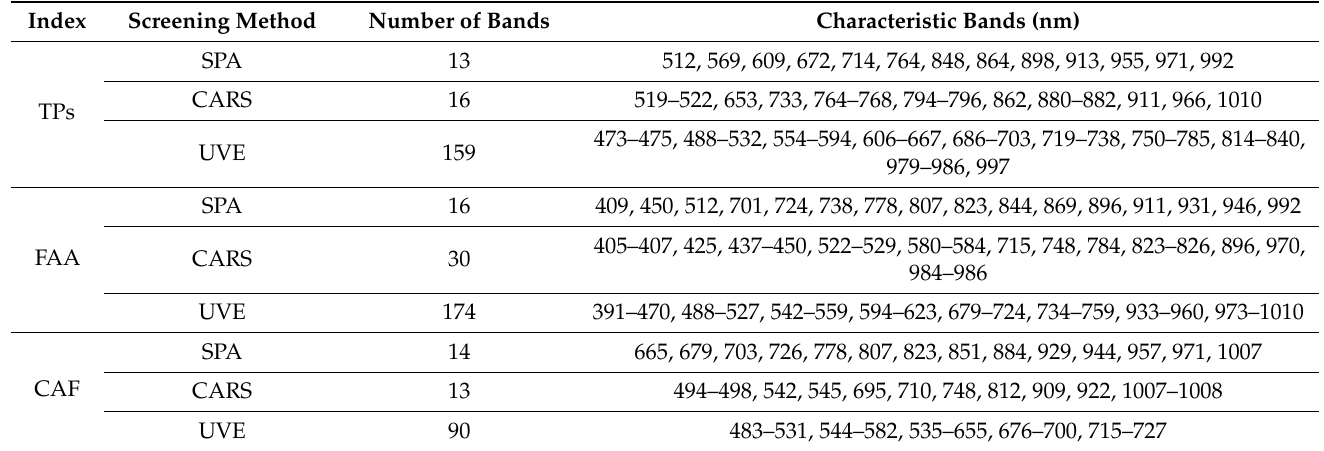
Figure 4. Distribution of characteristic bands. Table 3. Bands screening results.